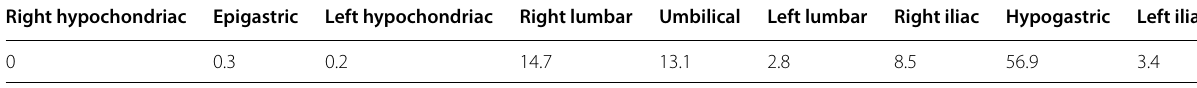
With spatial weighting, the proportion of highlighted abdominopelvic volume decreased while keeping an acceptable probability of missing the TZ (Fig. 6).